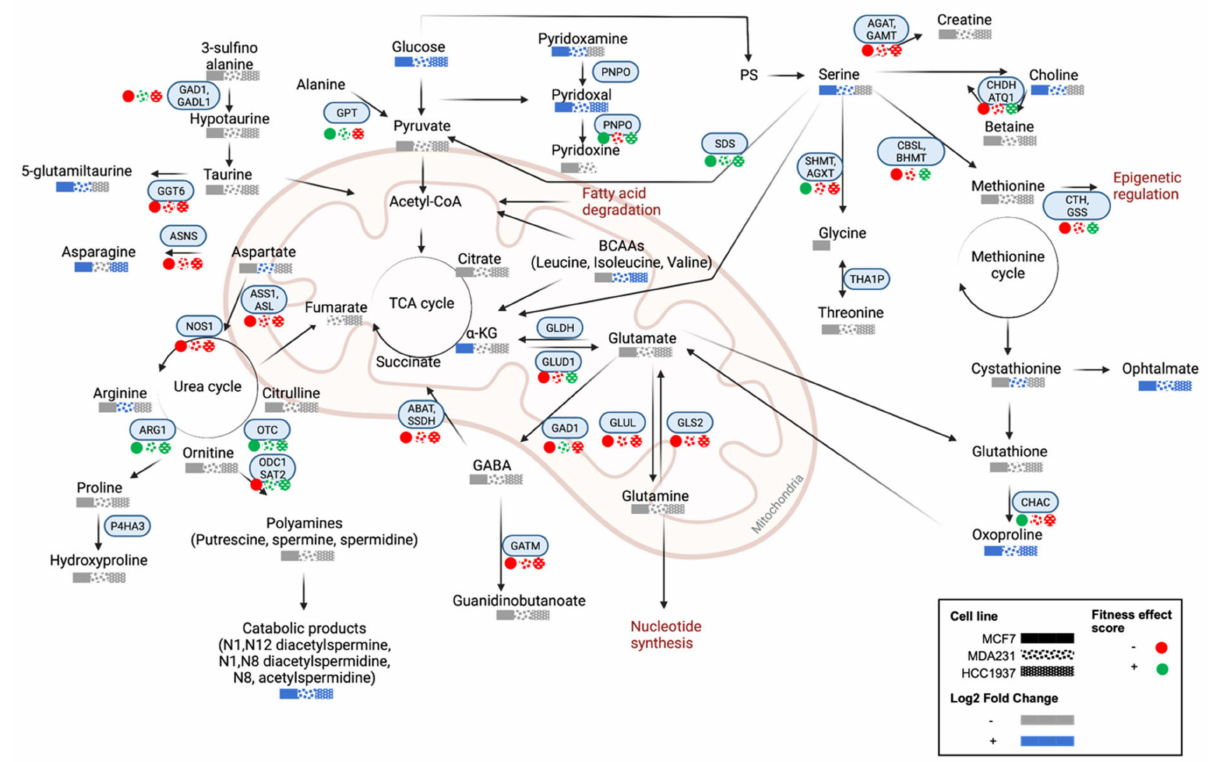
Figure 7. A summary of putatively identified metabolic pathways altered in response to olaparib exposure at IC 50 doses. Significantly altered features with a Log2 fold change of >1.5 (blue-enriched and grey-depleted). Fitness effect score of metabolic enzymes (light-blue boxes) in relation to PARP expression in each cell line. Positive and negative scores are in green and red, respectively. MCF-7 ( ), MDA-MB-231 ( ), and HCC1937 ( ). Fitness effect score is based on the Chronos